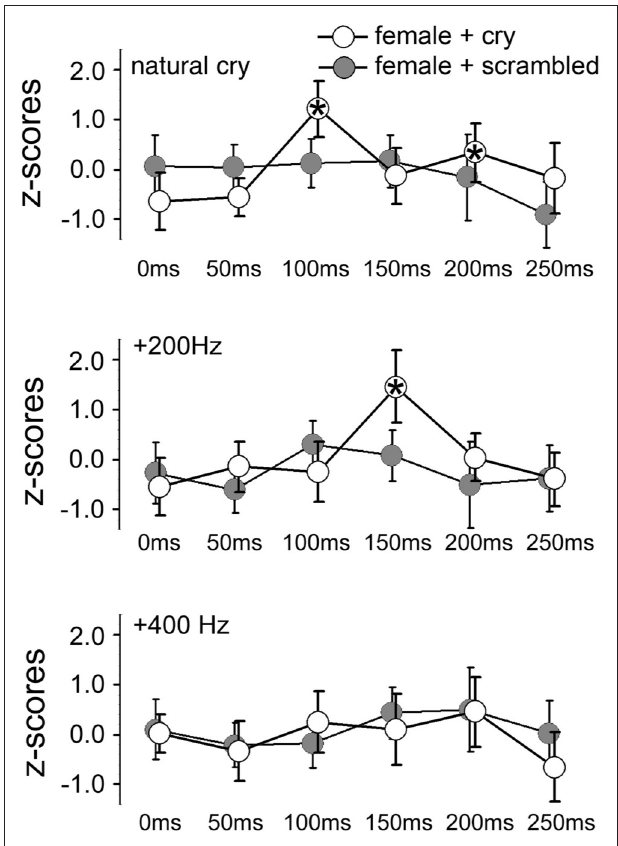
FIGURE 3 | Mean z -scores for each sound type and each ISI in the two groups of females (main and control experiments). Bars indicate 95% CIs. Asterisks indicate ISIs at which a significant difference was found with data obtained at 0ms